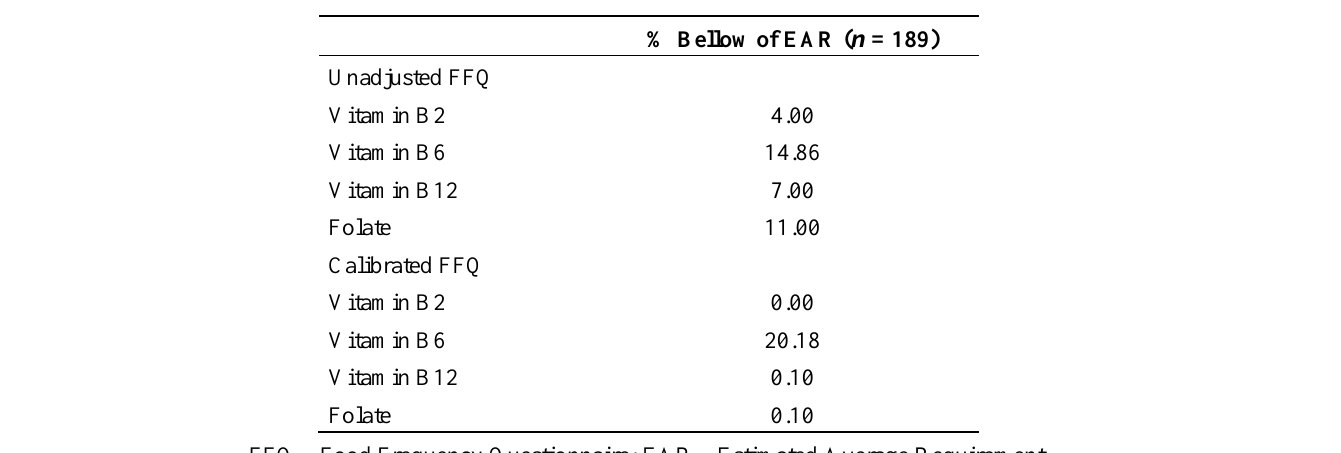
Table 6. The prevalence of inadequacy of vitamins B2, B6, B12 and folate in the pretreatment of patients for colorectal adenocarcinoma.